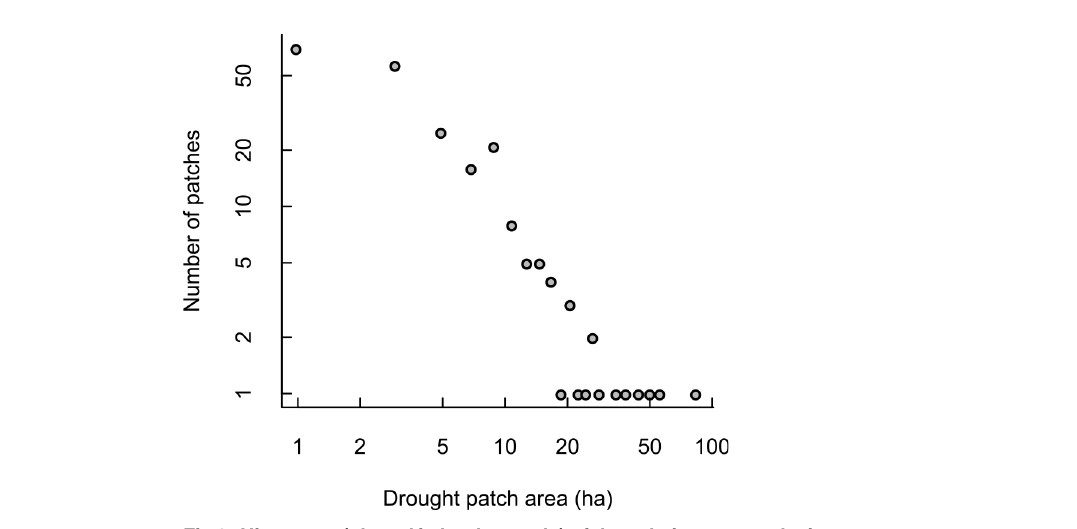
Fig 2. Histogram (plotted in log-log scale) of drought impact patch